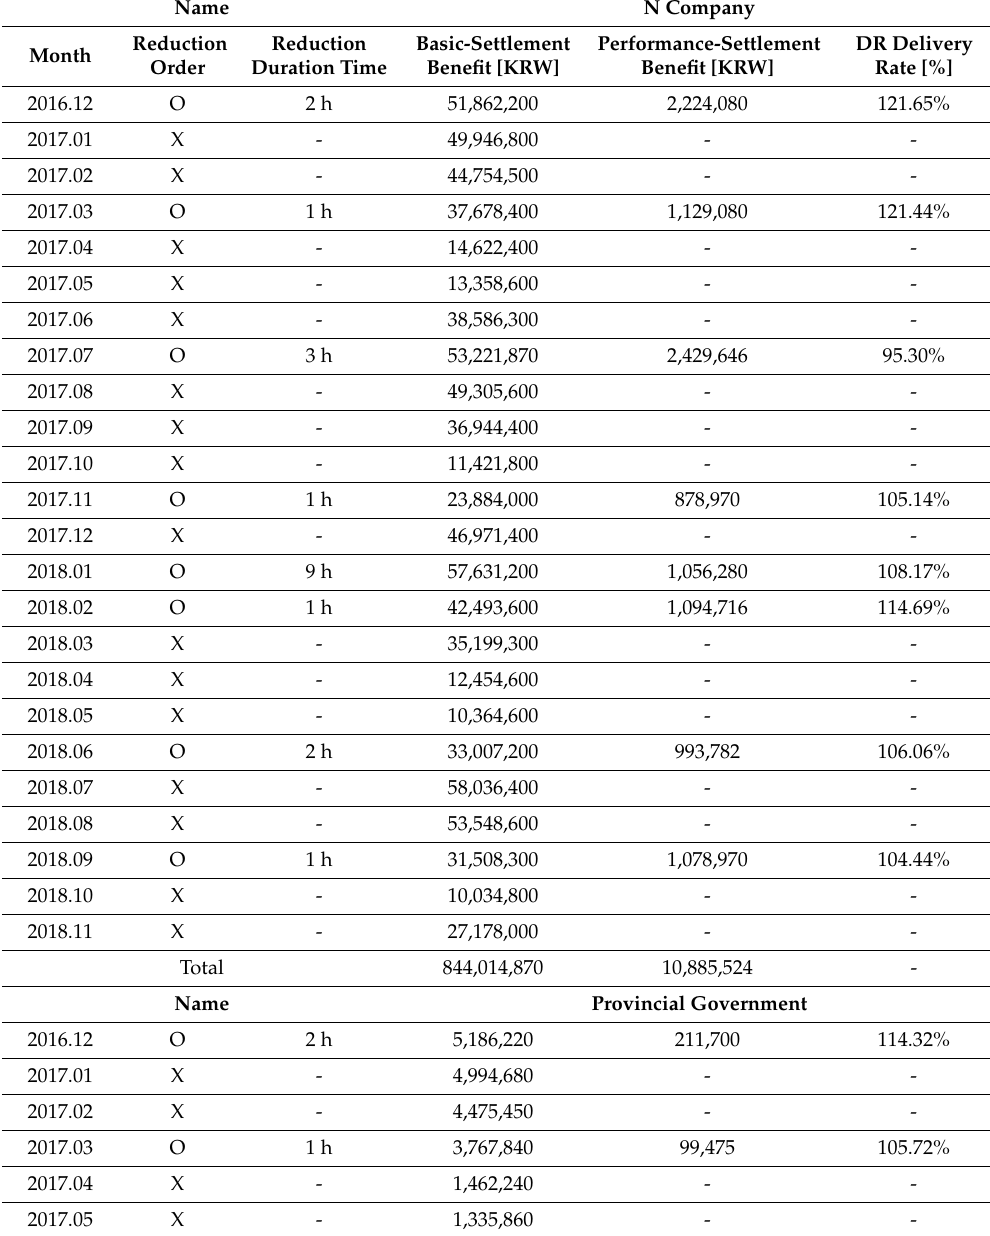
Table 6. Participation result of annual demand response